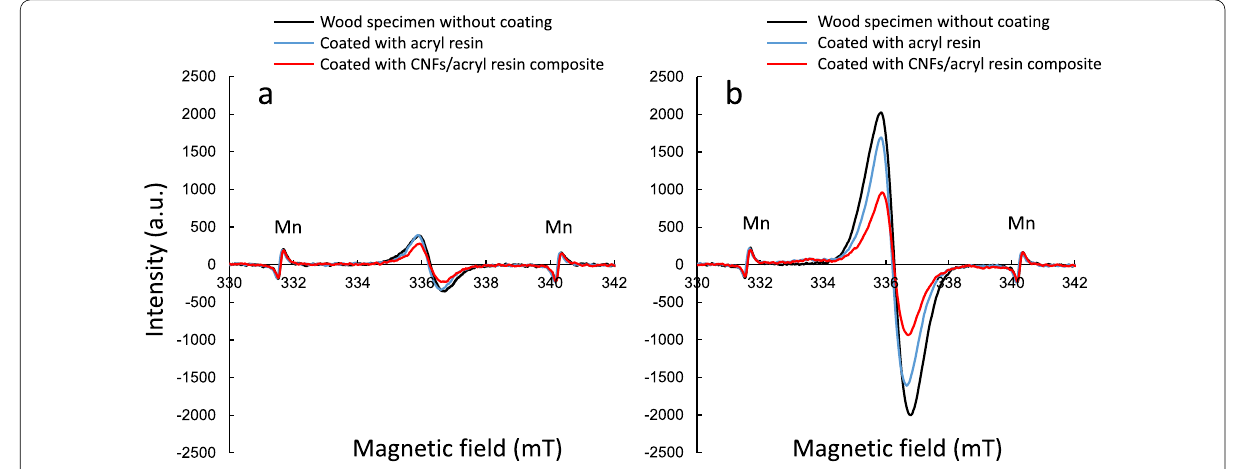
Fig. 6 Electron spin resonance spectra of before ( a ) and after ( b ) 2 min of UV irradiation. Mn was used as a